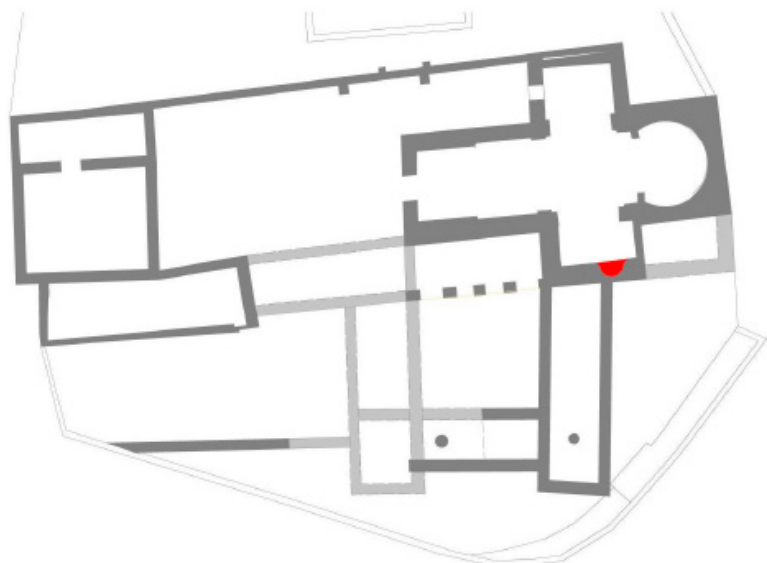
Figure 11. Floor plan of the church of Santa Maria de Terrassa, cloister and monastery quarters. According to A. Moro and G. Garcia.